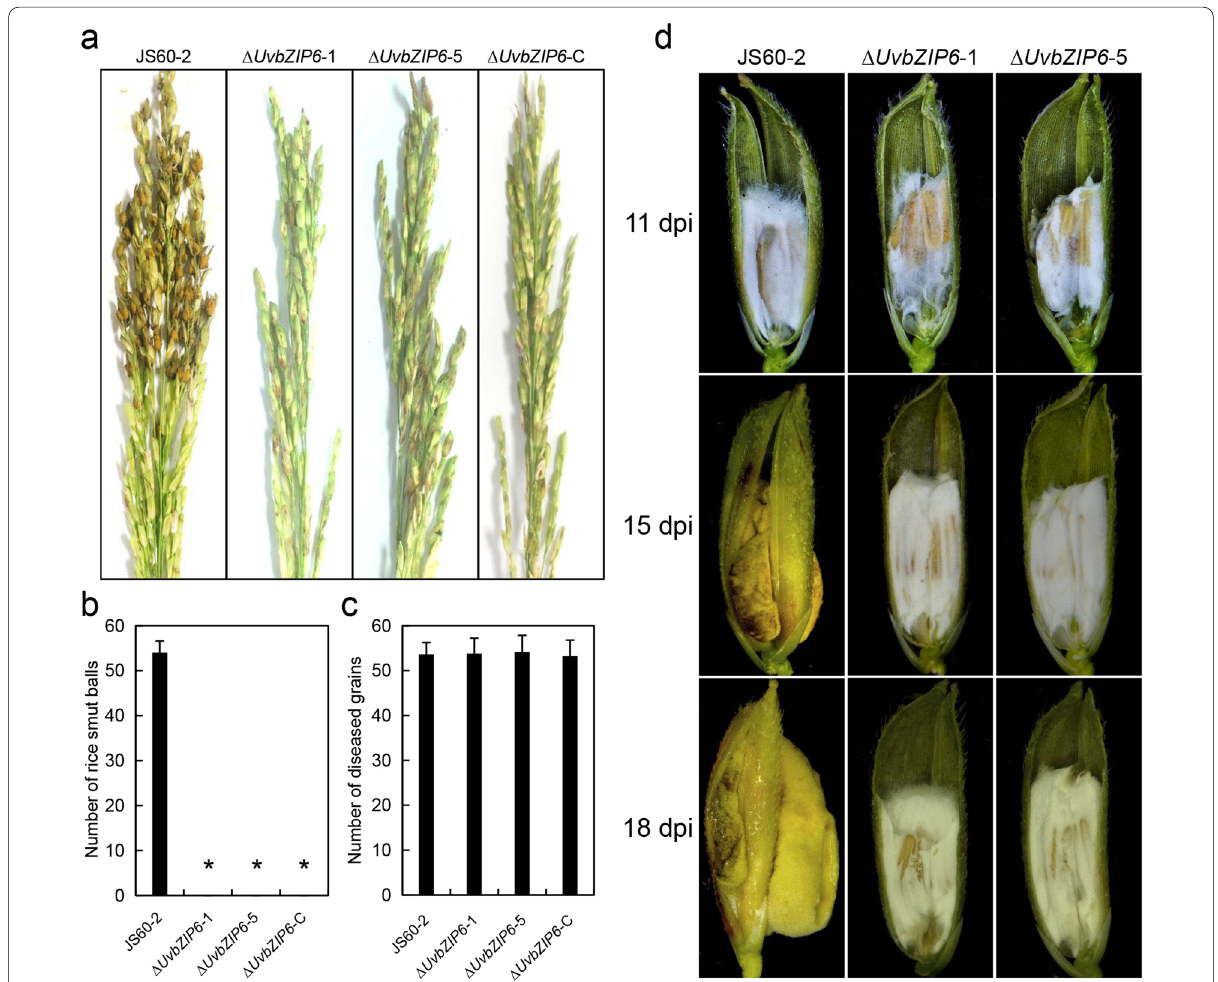
Fig. 6 UvbZIP6 contributes to false smut formation. a Symptoms of rice panicle inoculated with the WT, UvbZIP6- knockout mutants, or complemented strains. The suspension containing conidia and mycelia was injected into individual rice panicles, and the symptoms were investigated at 21 dpi. b The number of smut balls per panicle produced by the indicted U. virens strains. c The number of infected grains per rice panicle. d Comparison of the infection process of the WT and UvbZIP6 mutants on rice panicle at 11, 15, and 18